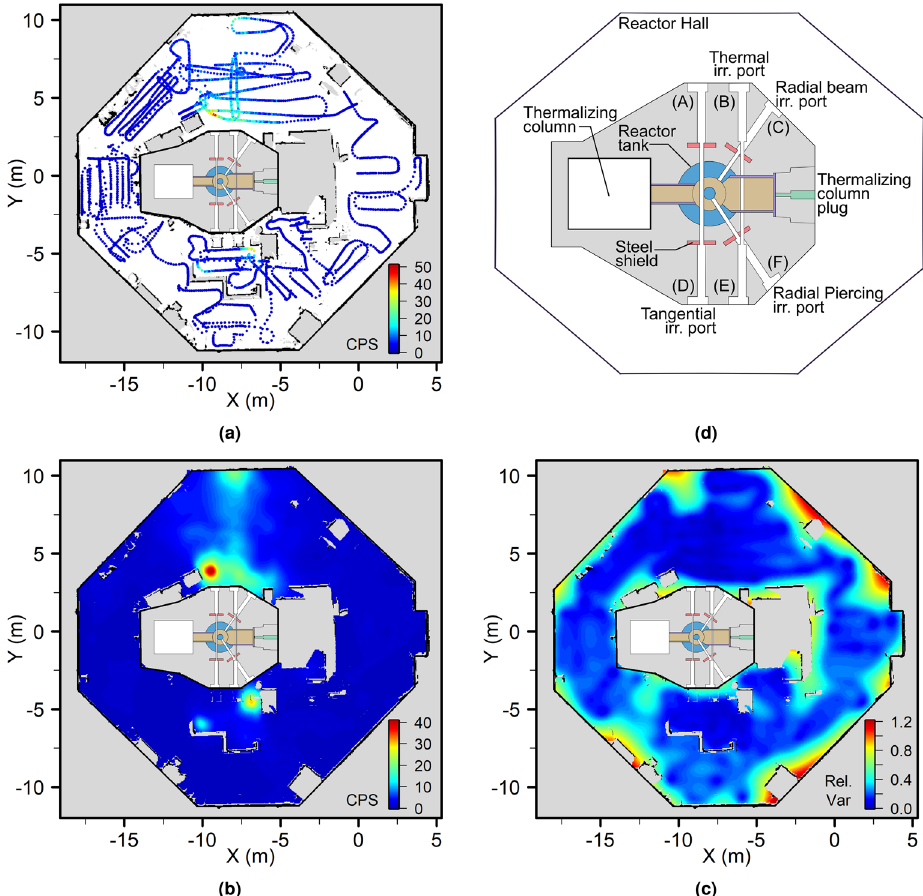
Figure 5. Spatially-resolved gamma radiation data overlaid on an occupancy grid generated through SLAM ( a ), and the interpolated map of radiation intensity ( b ). Blue indicates low (background) count rate through to red indicating greater counts per second. Part ( c ) shows the relative estimate variance, with blue being high confidence (low variance) and red representing low confidence. Part ( d ) shows a top view schematic of the JSI TRIGA Mark II reactor. The core is situated roughly central in the octagonal reactor hall, with irradiation ports marked by letters A–F. (Plots ( a )–( c ) generated using R version 3.6.1 43 https:// cran.r- proje ct. org/ bin/ windo ws/ base/ old/3. 6.1/, diagram ( d ) generated using Inkscape version 1.0.2 https:// inksc ape. org/ relea se/ inksc ape-1.